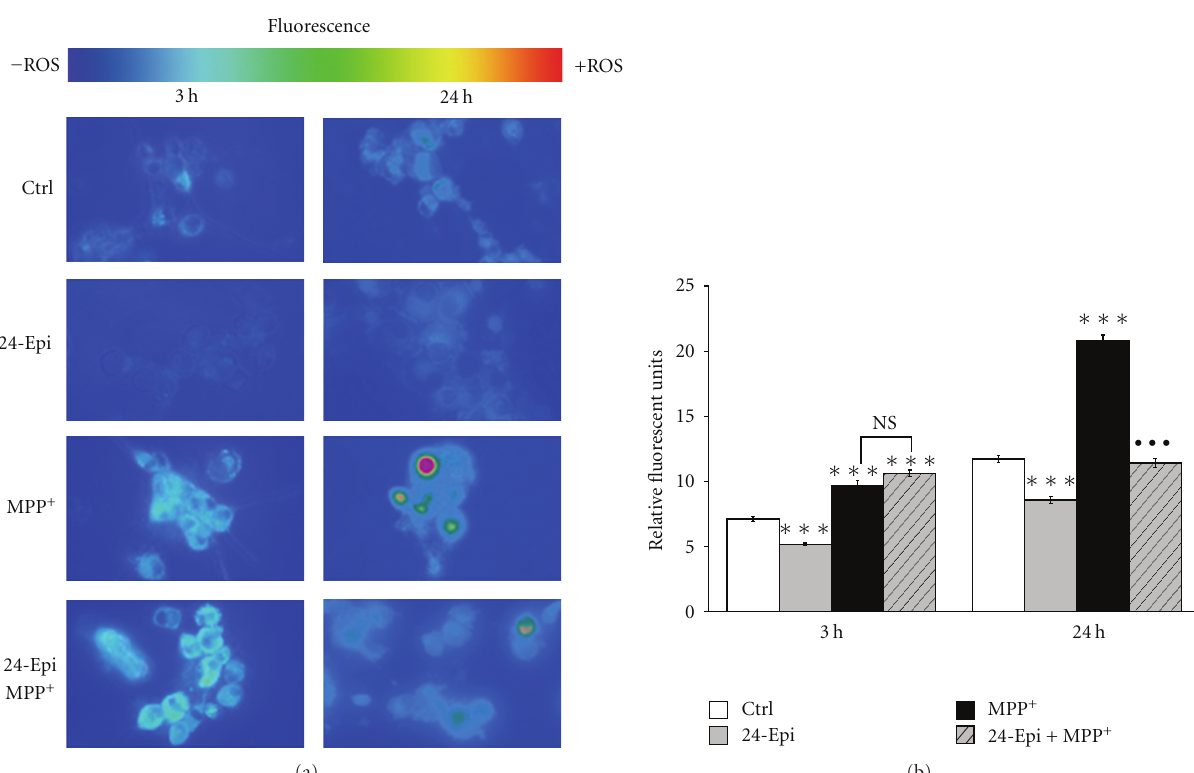
Figure 3: Rhodamine detection of ROS in neuronal PC12 cells after 3-hour and 24-hour treatment. Nonfluorescent DHR is converted to fluorescent rhodamine in the presence of several free radicals (OH • , NO 2 • , CO 3 •− , H 2 O 2 , HOCl, ONOO − ). (a) Fluorescence microphotographs after 3-hour or 24-hour treatment. Cells were pretreated with 24-Epi or vehicle (Ctrl) for 3h. Then, they were treated or not with MPP + for 3h or 24h. A marked signal of fluorescent rhodamine is evident in neuronal cells treated with MPP + but not in those exposed to the vehicle (Ctrl) or 24-Epi alone (24-Epi). A striking reduction of fluorescence is evident in cells pretreated with 24-Epi and then treated with MPP + (24-Epi + MPP + ) compared to cells pretreated with vehicle and treated with MPP + (MPP + ). (b) Semiquantitative image analysis of fluorescent cells after 3-hour and 24-hour treatment. Data are expressed as relative fluorescent units and are means ± S.E.M. Magnification 400x. n = 3. ∗∗∗ P < . 001 versus Ctrl and ••• P < . 001 versus MPP +